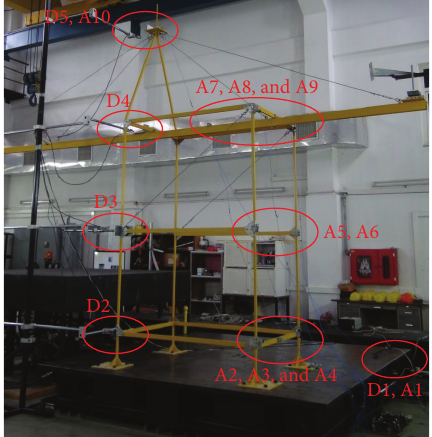
Figure 2: Location of the instruments on the physical